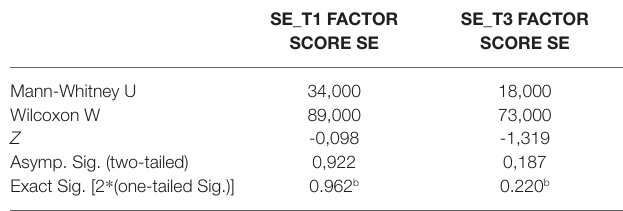
TABLE 4 | Test statistics table.